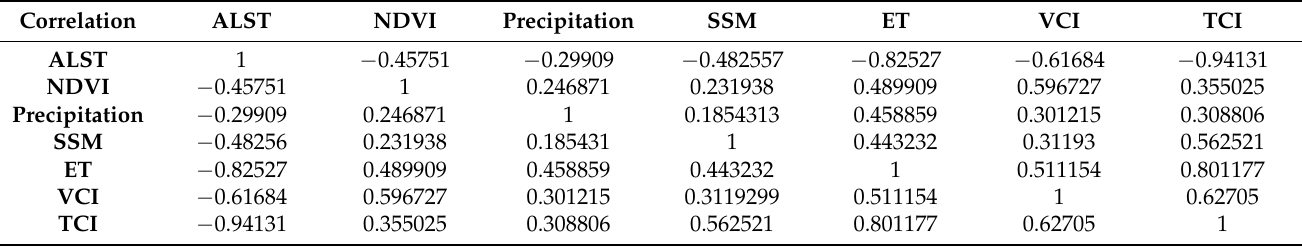
Table 7. Correlation between effective environmental factors of Qaleh-Ganj County.